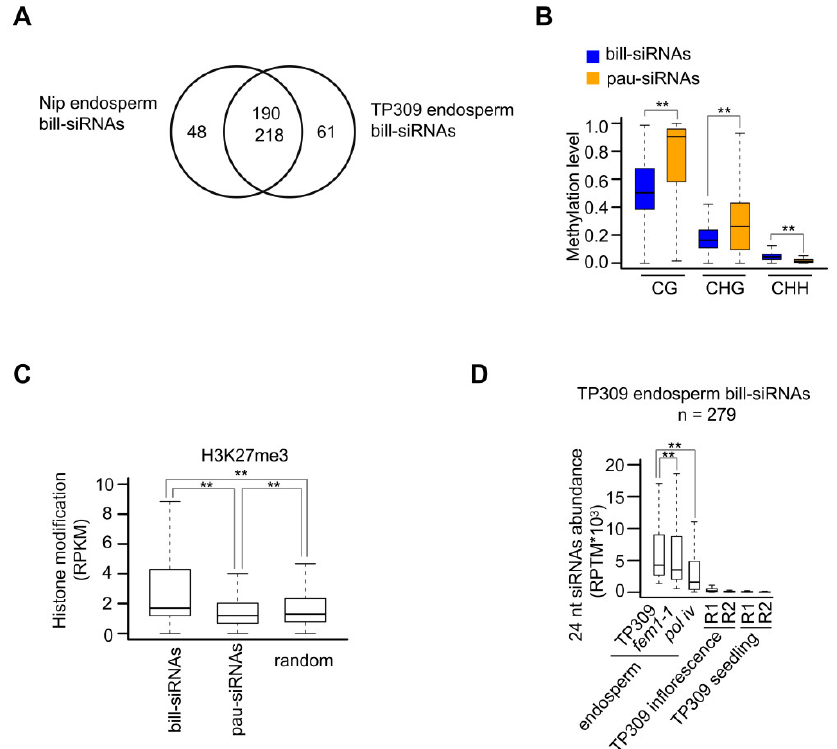
Figure 7. Biosynthesis of bill-siRNAs in the endosperm is dependent on OsRDR2 and Pol IV. ( A ) Overlap between bill-siRNAs in the endosperm of Nipponbare and TP309. ( B ) Boxplots showing the methylation levels in CG, CHG, and CHH on bill-siRNA and pau-siRNA clusters of the endosperm. ( C ) Comparison of H3K27me3 enrichment on bill-siRNA clusters and pau-siRNA clusters in the endosperm. ** indicates p < 0.01 by the Wilcoxon sum test. ( D ) Boxplots showing siRNA abundance on bill-siRNA clusters of TP309 endosperm. ** indicates p < 0.01 by the Wilcoxon sum test.